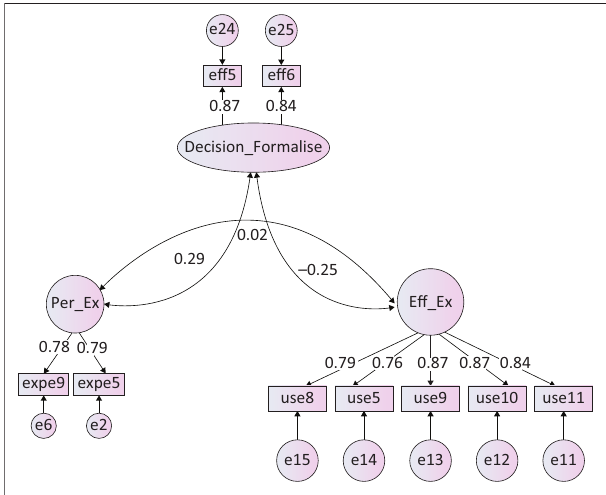
FIGURE 2: Final measurement model.